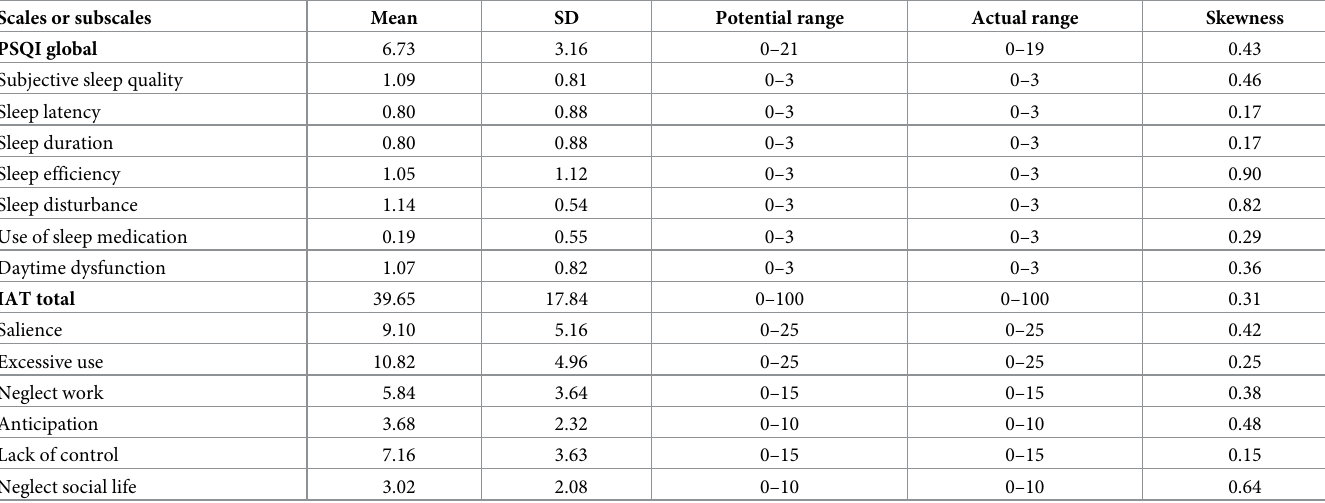
Table 2. Descriptive information for the Pittsburgh Sleep Quality Index (PSQI), Internet Addiction Test (IAT), and their subscales (N = 2749). Scales or